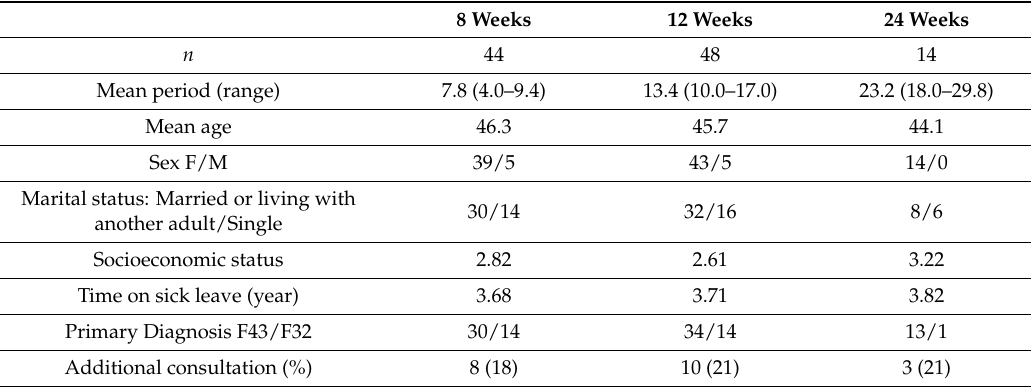
Table 1. Baseline characteristics for the patients participating in the different rehabilitation periods, ( n = 106).